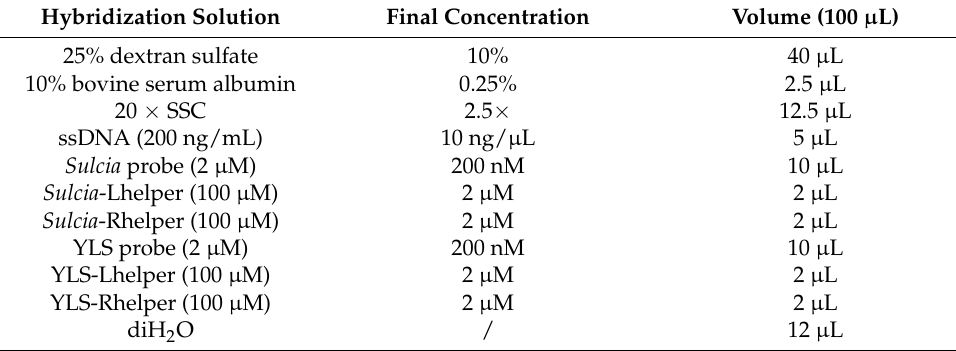
Table 2. The detailed hybridization solution used in this